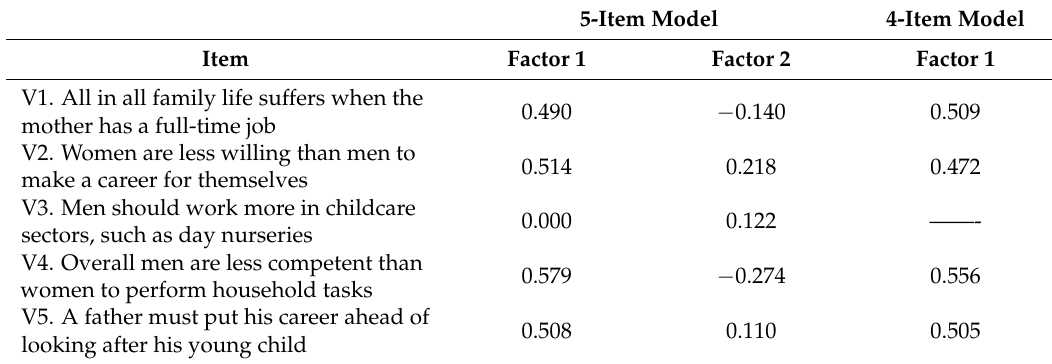
Table A2. Exploratory factor analysis results—factor loadings in the rotated factor